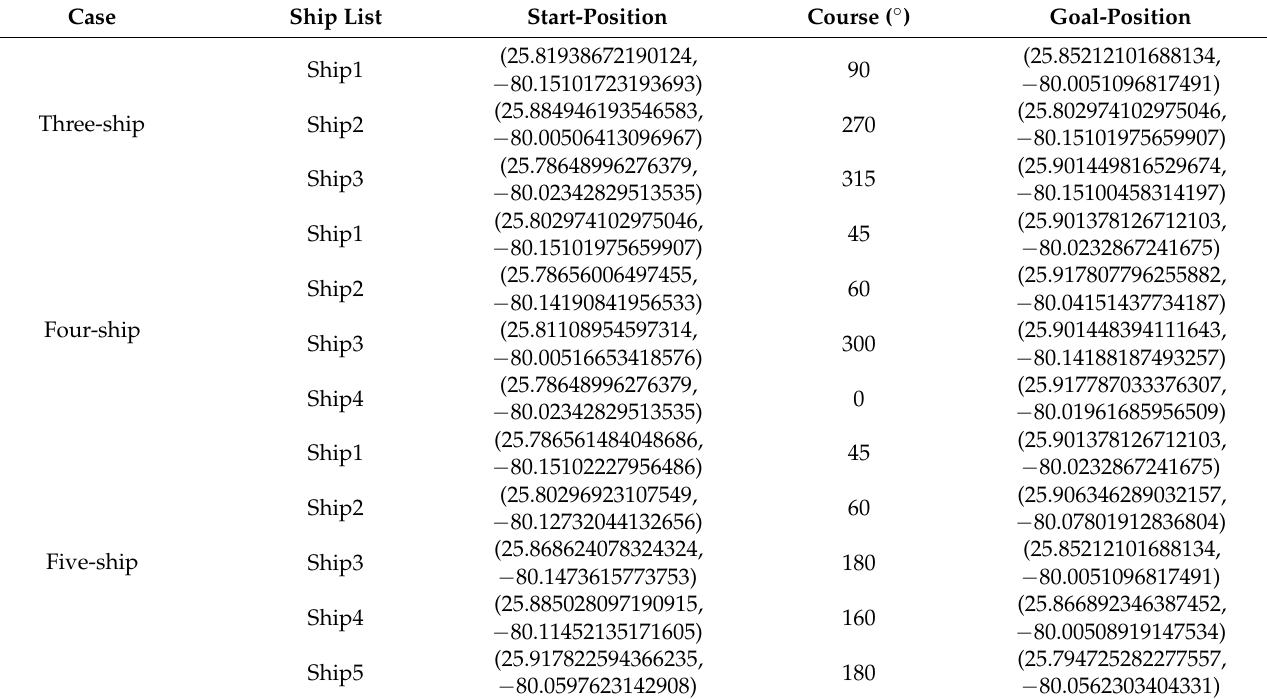
Table 2. Complex ship encounter